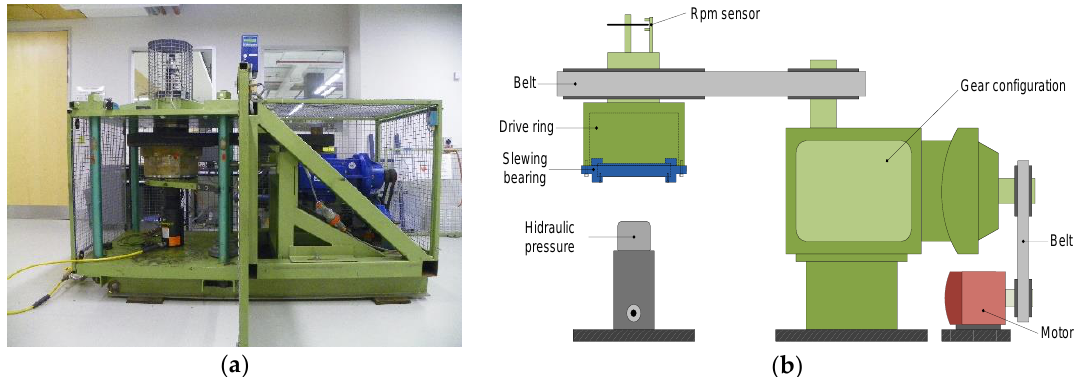
Figure 1. ( a ) Slew bearing rig picture; ( b ) Schematic of laboratory slew bearing rig showing a slew bearing attached in the drive ring and the applied load from the hydraulic.